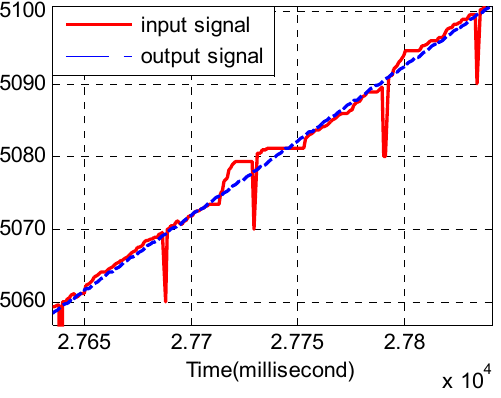
Figure 15. Partial enlarged drawing of Figure